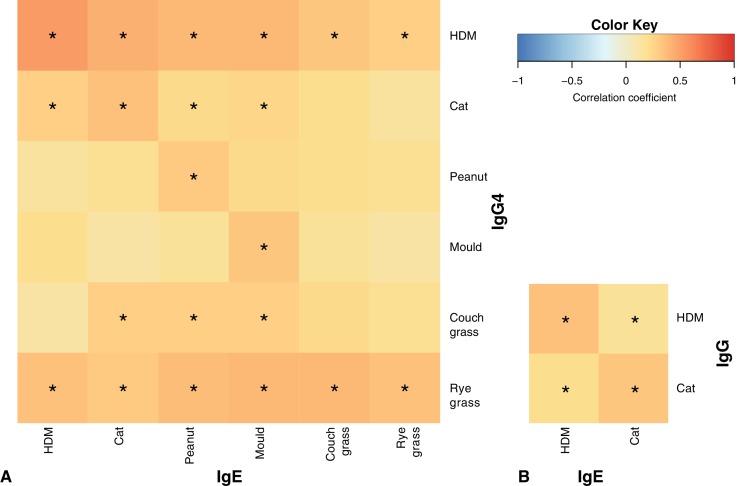
Correlation patterns between IgE vs IgG4 (A) and IgE vs IgG (B) at age five *p<0.05 for Spearman correlation with Holm correction for multiple testing.Note the slightly stronger heat along the main diagonals of both heatmaps, especially for HDM.